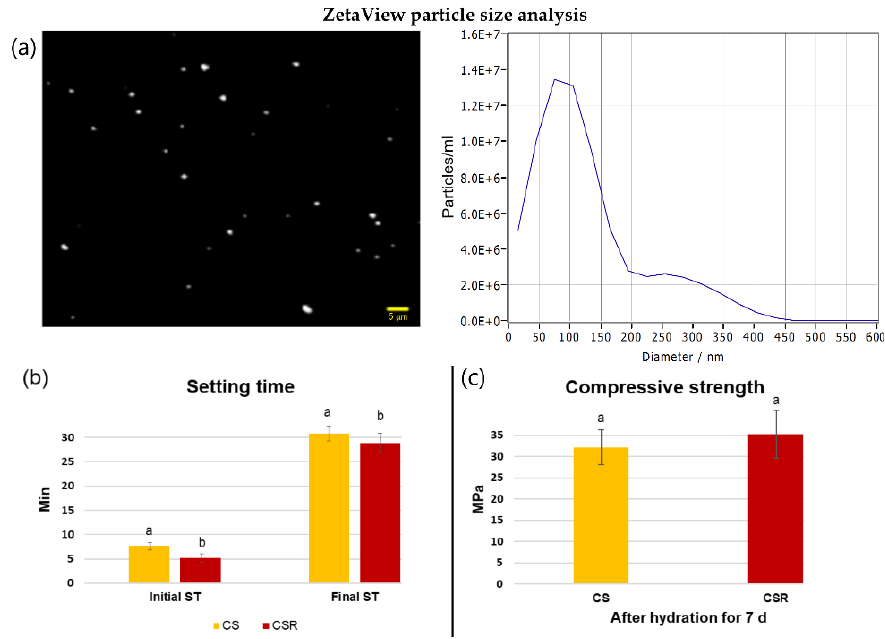
Figure 2. ( a ) ZetaView video and Zeta size distribution of CSR showing the average particles size of 86 nm. Physicochemical properties of the synthesized ceramics. ( b ) The initial and final setting times of CS and CSR. Different lowercase letters indicate significant differences between different groups within each setting time point as analyzed by t -test. ( c ) The compressive strength of CS and CSR after hydration for 7 days. No statistically significant difference was found between